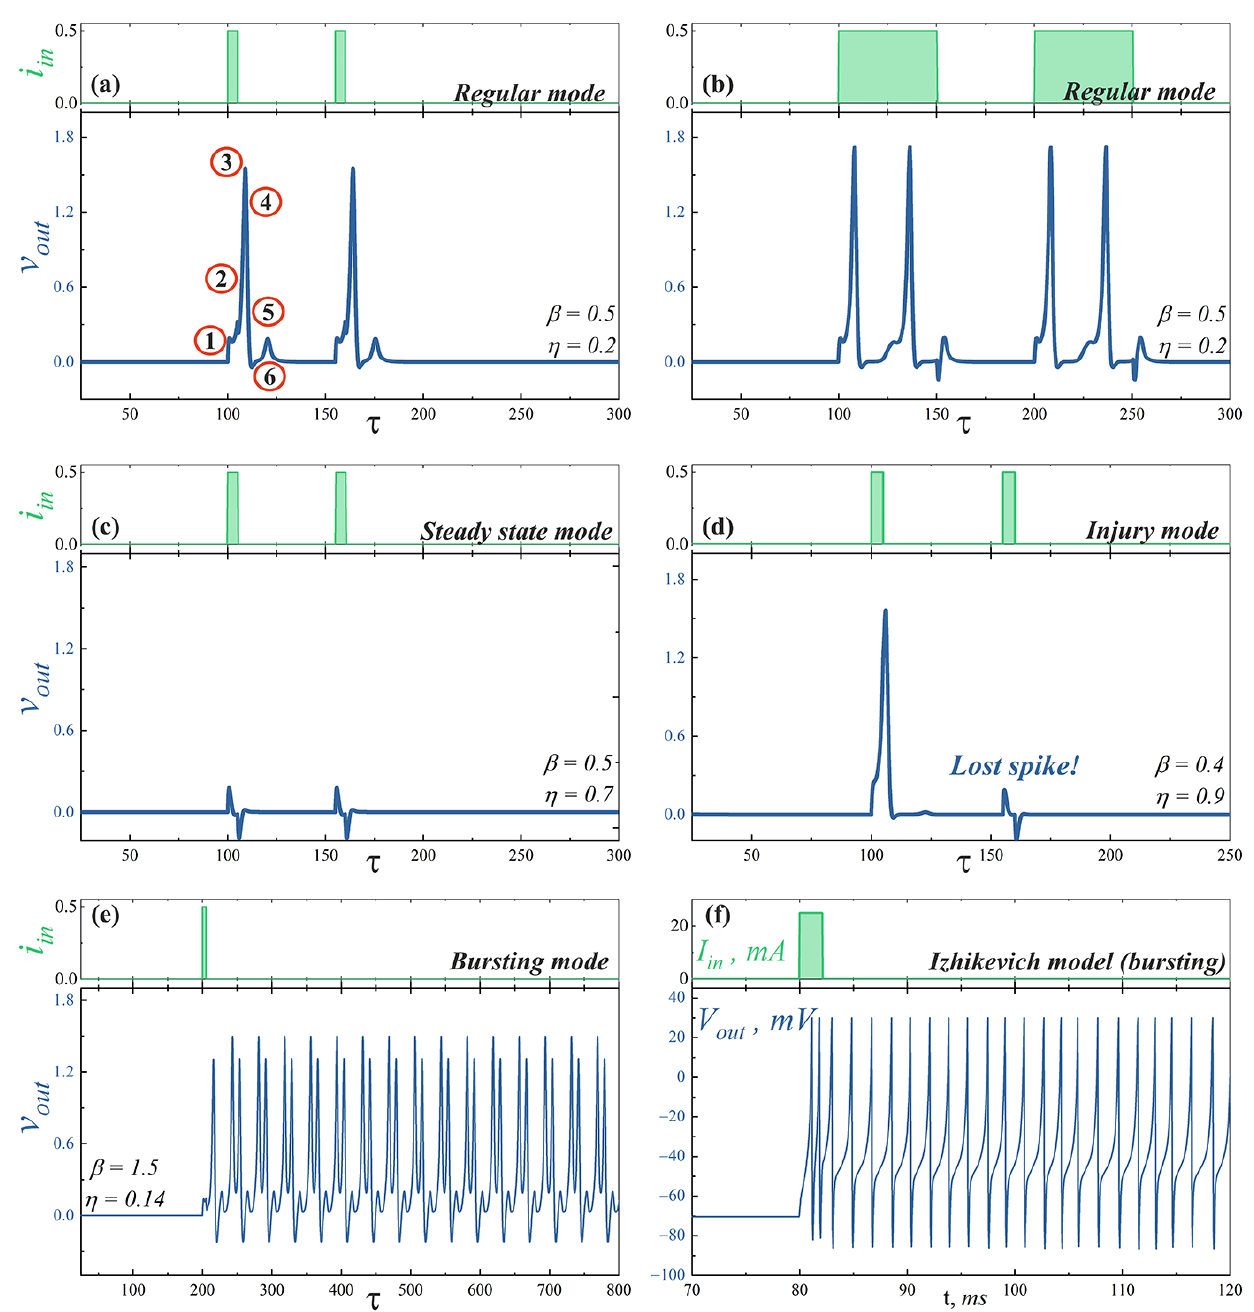
Figure 4. Simulations of the superconducting bio-inspired neuron dynamics in the various operation modes: ( a , b ) regular mode ( β = 0.5, η = 0.2), ( c ) steady state mode ( β = 0.5, η = 0.7), ( d ) injury mode ( β = 0.4, η = 0.9), and ( e ) bursting mode ( β = 1.5, η = 0.14). The figures show the output voltage across the second Josephson junction of the cell stimulated by the input current pulse. The circuit parameters are i b = 1.9, l = 5, l S = 3.85. ( f ) Bursting dynamics obtained in the framework of the Izhikevich model, see Figure S3d of Supplementary Materials and its description